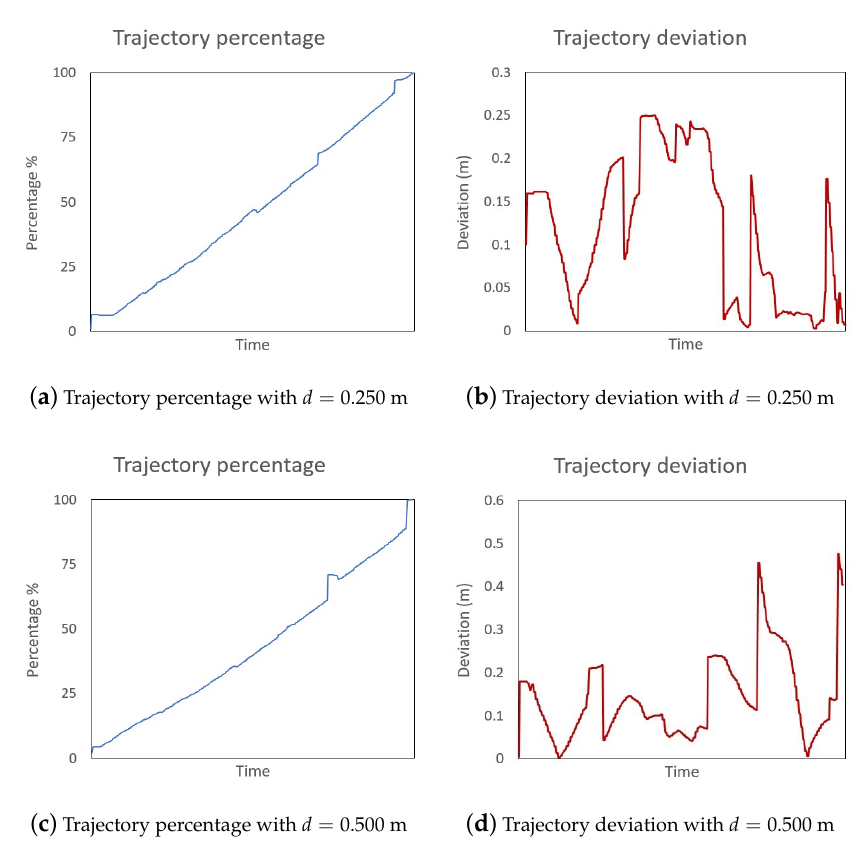
( a ) Trajectory percentage with d = 0.250 m ( b ) Trajectory deviation with d = 0.250 m